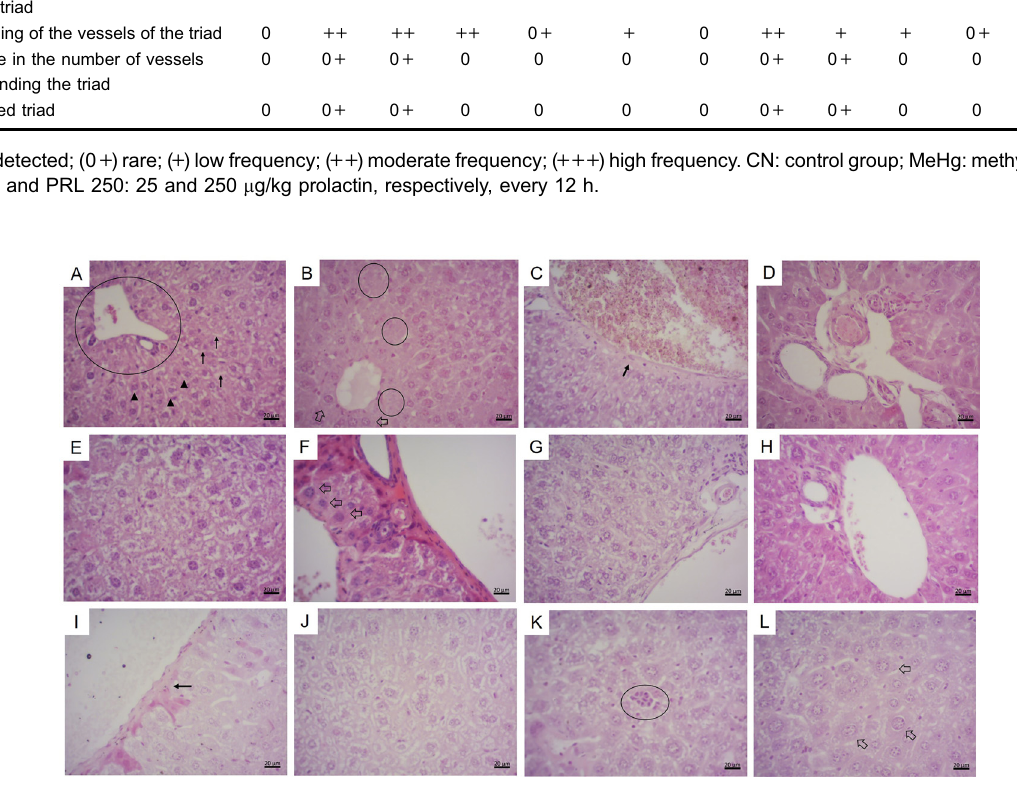
Figure 1. H&E liver histology. A , Female - negative control group: normal liver tissue, portal space (circle), sinusoids (arrows), and hepatocytes (arrowheads). B , Male - MeHg group: hypertrophied hepatocytes (arrows) and areas with cells in karyolysis (circles). C, Male - MeHg group: triad vein wall thickening (arrow). D , Male - MeHg group: triad with an increase in the number of structures. E , Male - PRL 25 group: area with edema. F , Female - PRL 25 group: hypertrophied hepatocytes (arrows). G , Female - PRL 250 group: area with edema. H , Male - PRL 250 group: normal liver tissue. I , Male - MeHg + PRL 25 group: triad vein wall thickening (arrow). J , Female - MeHg + PRL 25 group: area with edema. K , Male - MeHg + PRL 250 group: in fl ammatory in fi ltrate (circle). L , Female - MeHg + PRL 250 group: hypertrophied hepatocytes (arrows). Scale bar: 20 m m. MeHg: methylmercury; PRL 25 and PRL 250: 25 and 250 m g/kg prolactin, respectively, every 12